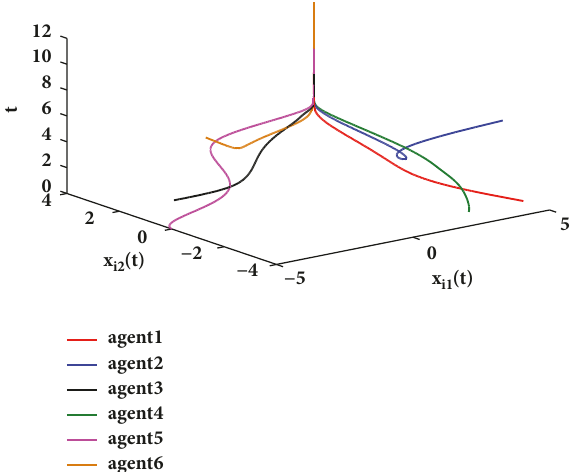
Figure 3: The states of six agents in two-dimensional space.